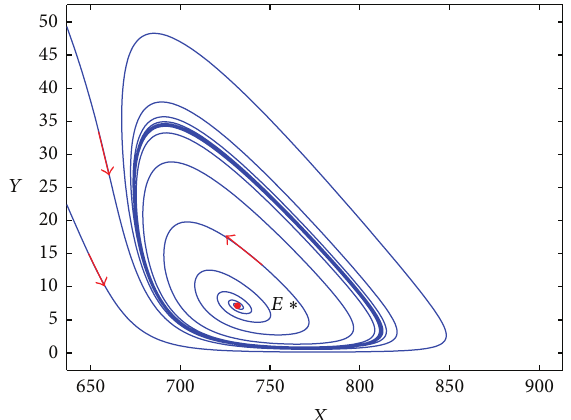
Figure 6: Phase plane of 𝑋 − 𝑌 with 𝐴 = 150 , 𝑑 = 0.1 , 𝑎 = 0.001 , = 1 , and 𝑐 = 0.5 (color 𝑏 = 0.01 , 𝑐 1 2